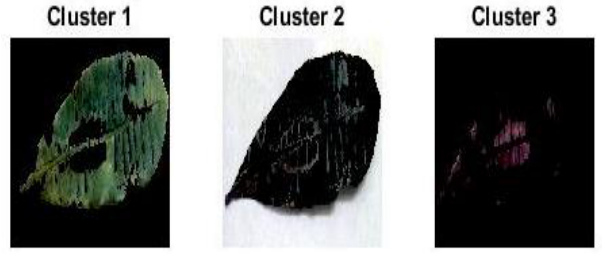
Figure 10. Cluster size 3 and 90 °co-occurrence